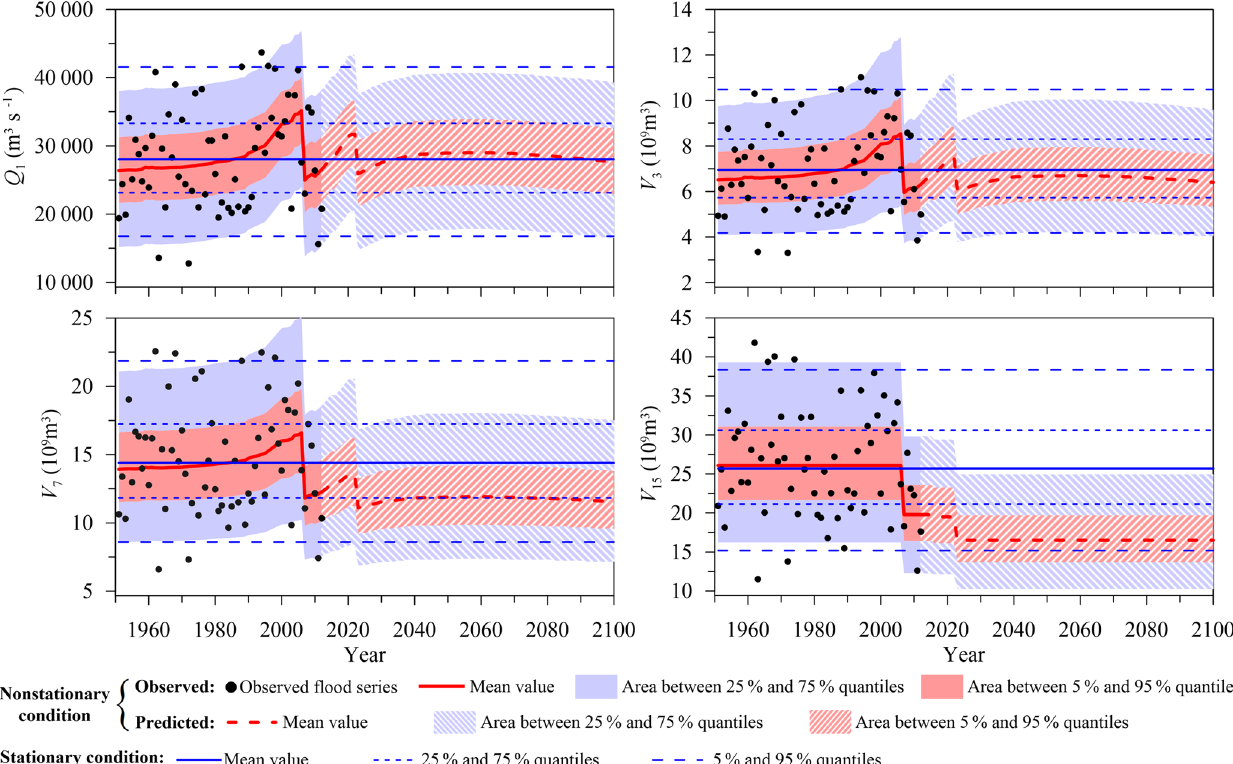
Figure 4. Nonstationary marginal distributions during both the observation and design life periods.